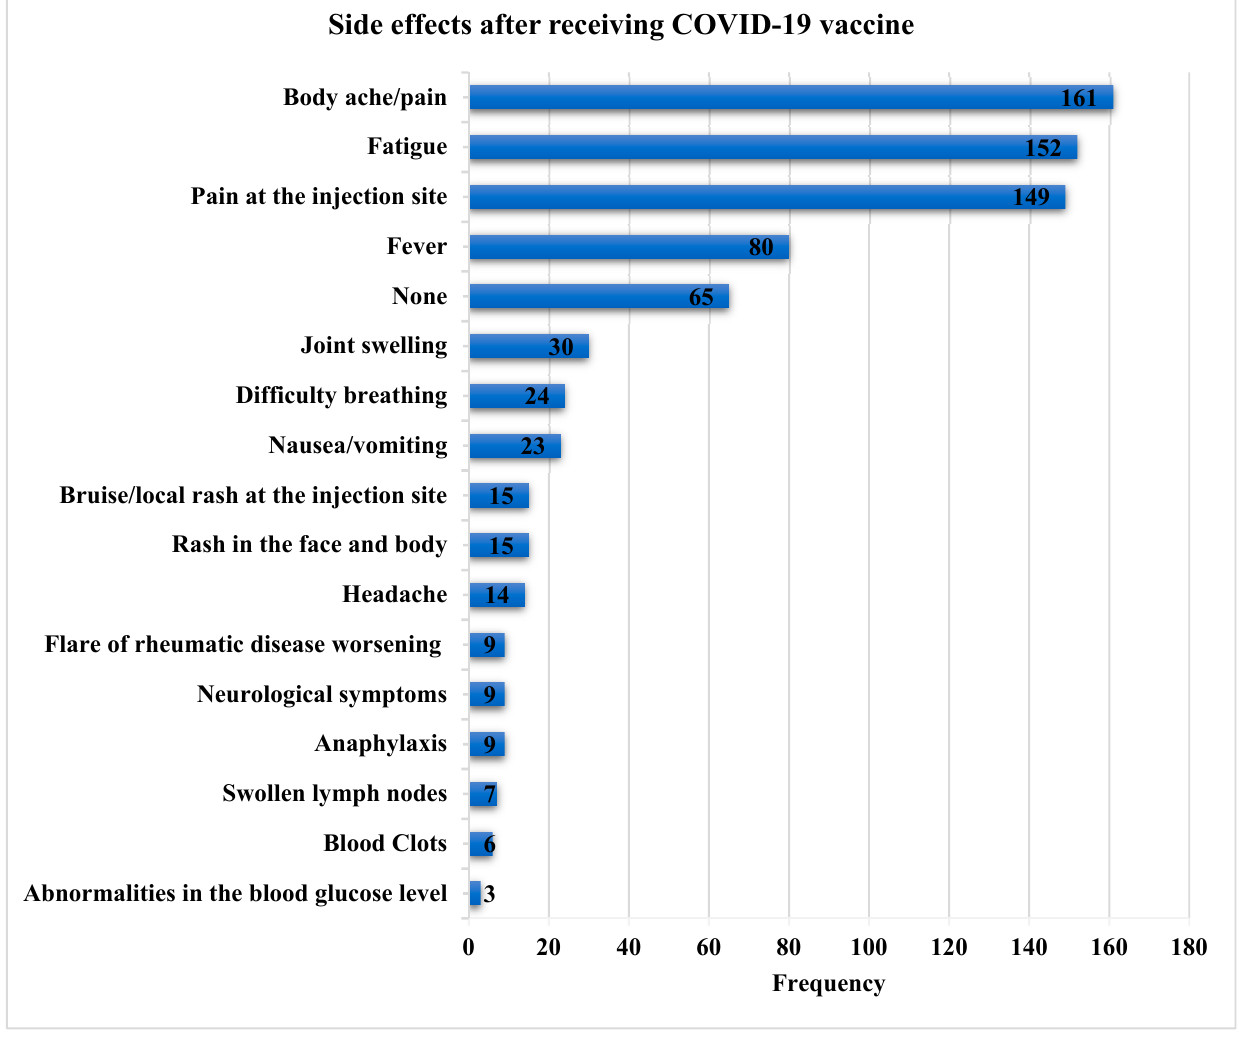
Figure 3. Bar chart showing the frequency of side effects after receiving the SARS-CoV-2 vaccine.